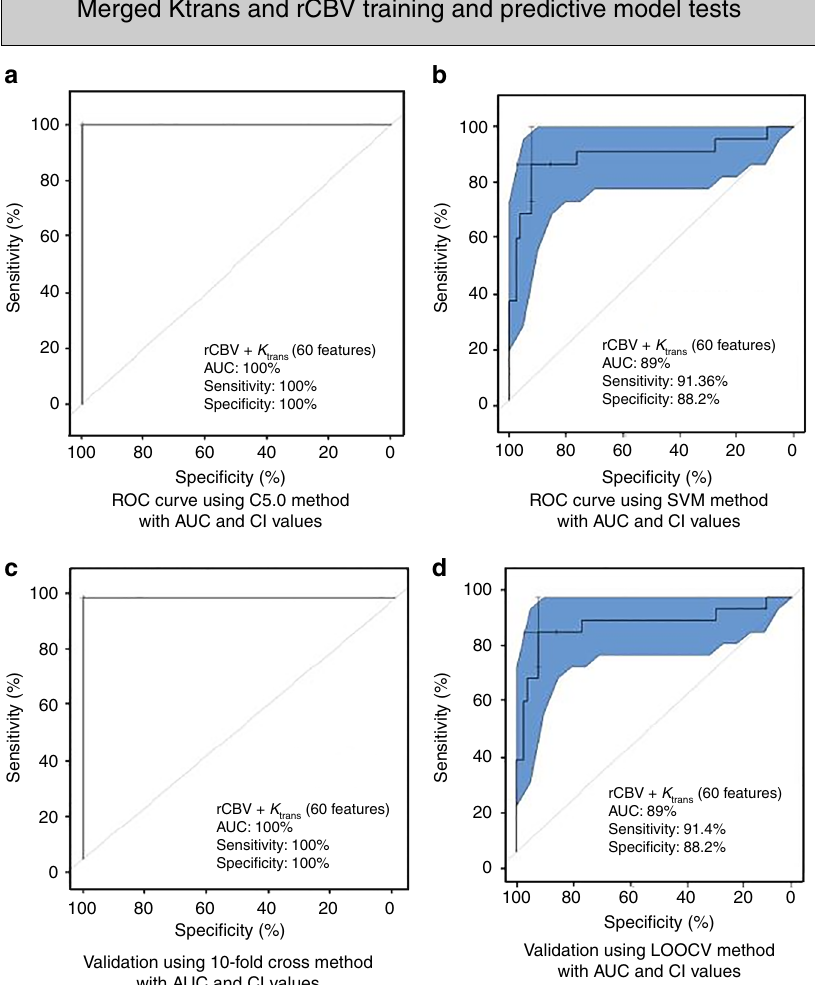
Validation using LOOCV method Validation using 10-fold cross method with AUC and CI values with AUC and CI values Fig. 4 Model building and evaluation using the selected merged K trans and rCBV features (60 features). a , b ROC curve depicts the predictive model building using C5.0 ( P -value 1.512e − 11) and SVM methods ( P -value 0.017), respectively. c , d 10-fold cross-validation ROC curve ( P -value 1.512e − 11) and Leave-One-Out Cross-Validation (LOOCV) ROC curve ( P -value 0.02) depicts the performance of the